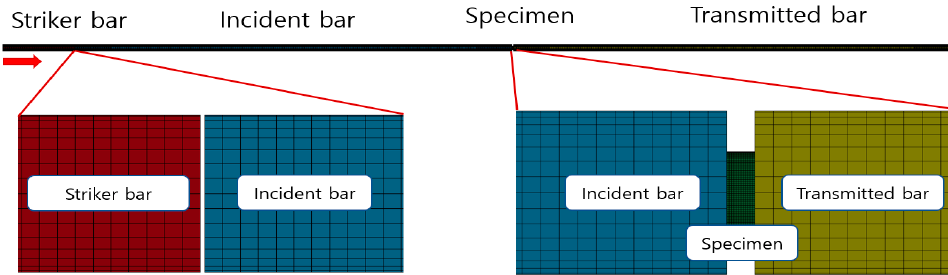
Figure 5. SHPB apparatus FEM modeling in LS-DYNA. Table 4. Material properties of Al6061-T6.